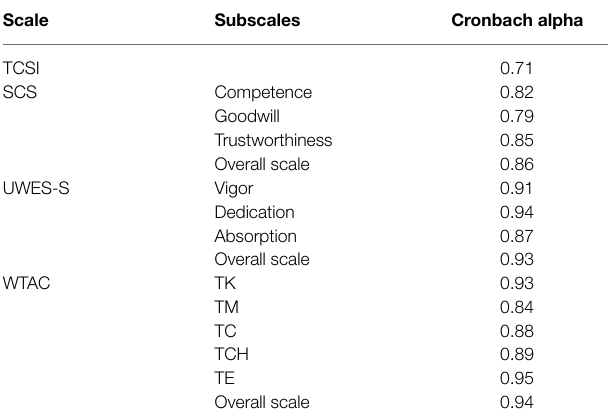
TABLE 3 | Results of Cronbach alpha